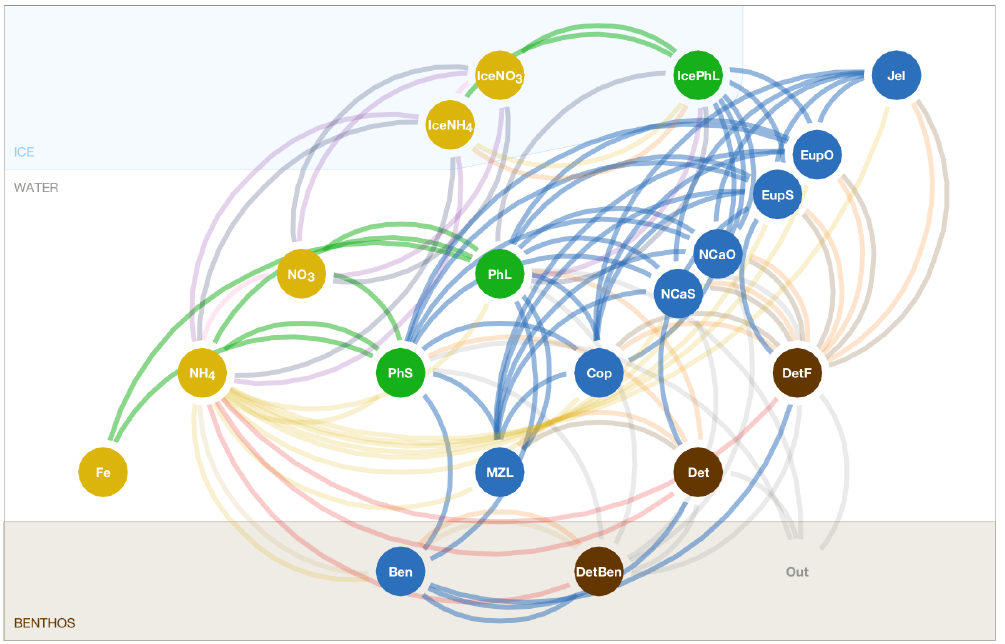
Figure A1. Schematic of the BESTNPZ model. Circular nodes represent state variables (gold indicates nutrient, green indicates producer, blue indicates consumer, brown indicates detritus). Edges (lines) represent fluxes between state variables and curve clockwise from source node to sink node. Edge colors indicate process type: green indicates primary production, blue indicates grazing and predation, brown indicates egestion, gold indicates respiration, red indicates remineralization, pink indicates nitrification, orange indicates non-predatory mortality, tan indicates excretion, purple indicates convective exchange, gray indicates sinking to seafloor, and navy indicates freezing/melting of ice.